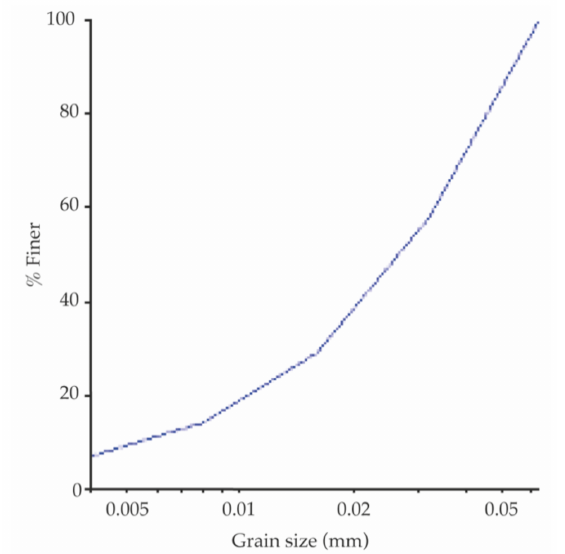
Figure 10. HEC-RAS granulometric distribution; grain size in mm on the x -axis and sieve in percent- age (%) on the y